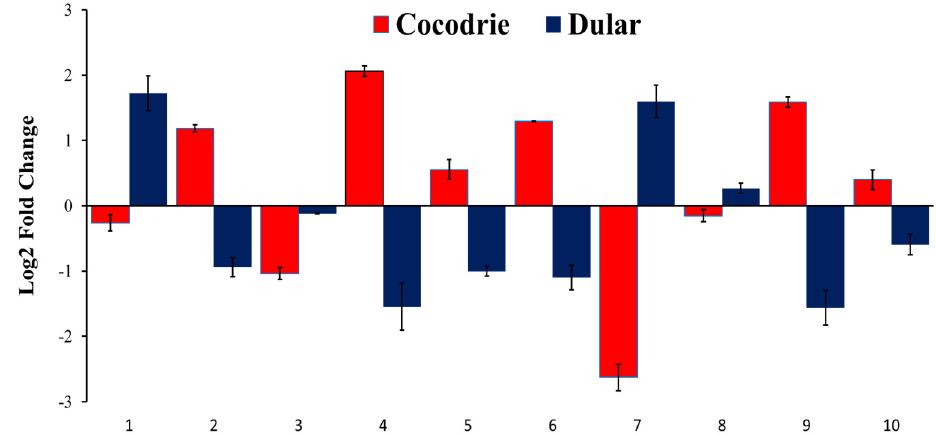
Figure 5. The expression level of selected genes in Cocodrie and Dular 6 h after exposure to alkalinity stress. EF1 α was used as the reference gene. Log2 fold change was calculated for gene expression analysis under alkaline stress compared with control. 1–10 represents the genes used for expres- sion analysis. 1-LOC_Os03g59730; 2-LOC_Os03g62430; 3-LOC_Os03g62370; 4-LOC_Os03g62379; 5- LOC_Os08g02050; 6-LOC_Os08g44690; 7-LOC_Os09g39100; 8-LOC_Os10g34650; 9-LOC_Os10g34490;